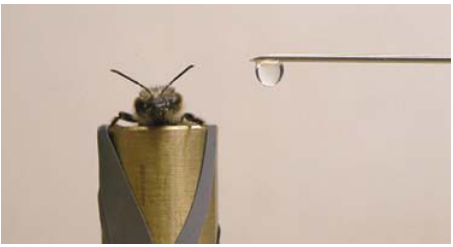
Figure 2. A photograph of lateral presentation of the odour as in experiment 2.